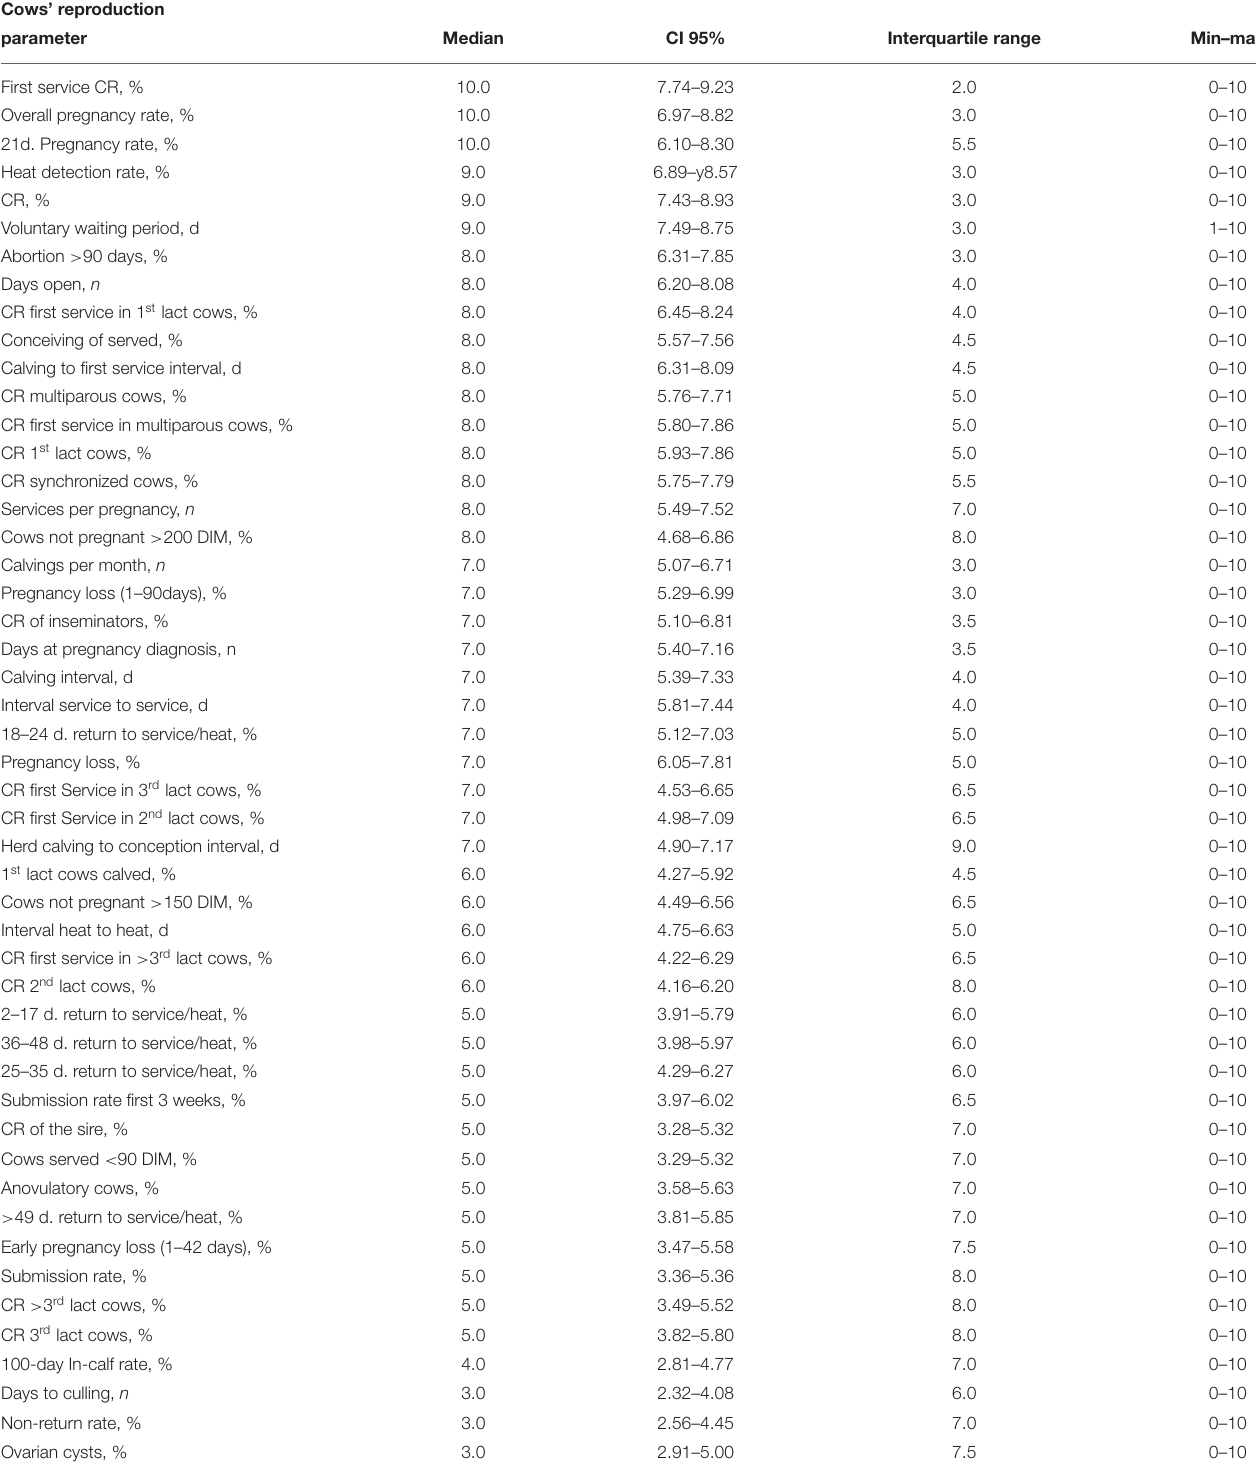
TABLE 3 | Answers given by consultants on Section 3: Cows’ Reproduction data parameters, where 0 is of minimal or irrelevant importance and 10 represents the maximum importance. Cows’